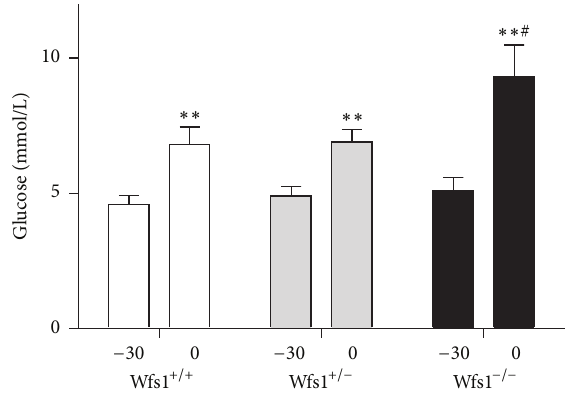
Figure 1: Stress-induced hyperglycaemia before IPGTT. Wfs1 +/+ , white bars; Wfs1 +/− , grey bars; Wfs1 −/− , black bars. Repeated mea- sures ANOVA, followed by the Duncan post hoc test, where ∗∗ 𝑝 < 0.01 versus time point − 30; # 𝑝 < 0.05 versus other genotypes at time point 0. Data of saline treated animals were pooled from two independent experiments. 𝑛 = 16 in all groups.